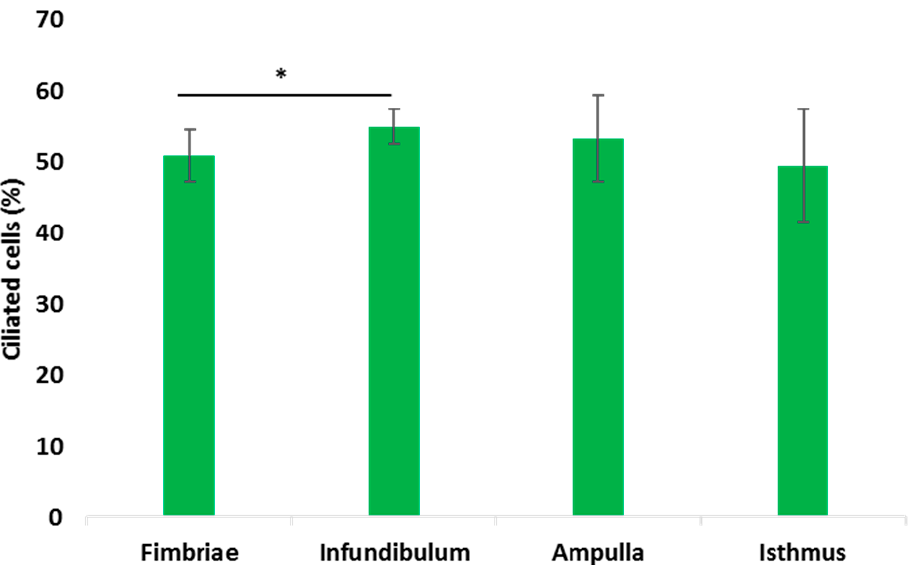
Figure 9. The mean percentages of ciliated cells in the epithelium of the baboon Papio hamadryas during the preovulatory phase. Values were expressed as means ± standard deviation (S.D.). Statistical differences: *, p ≤ 0.05.